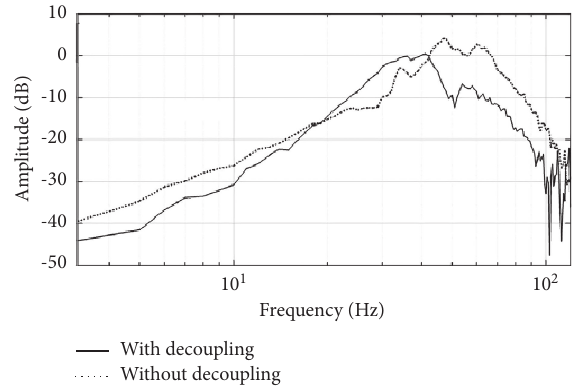
Figure 12: Comparison of random signal before and after decoupling with eccentric load.